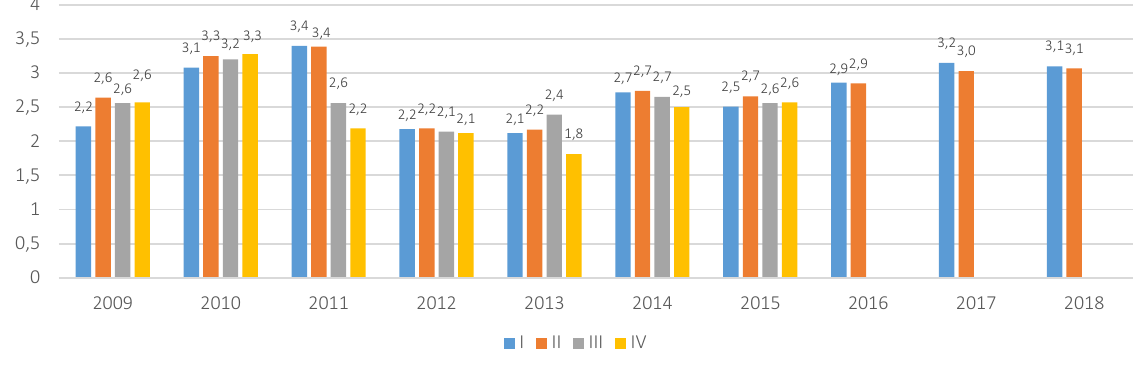
Figure 6. Investment Attractiveness Index of